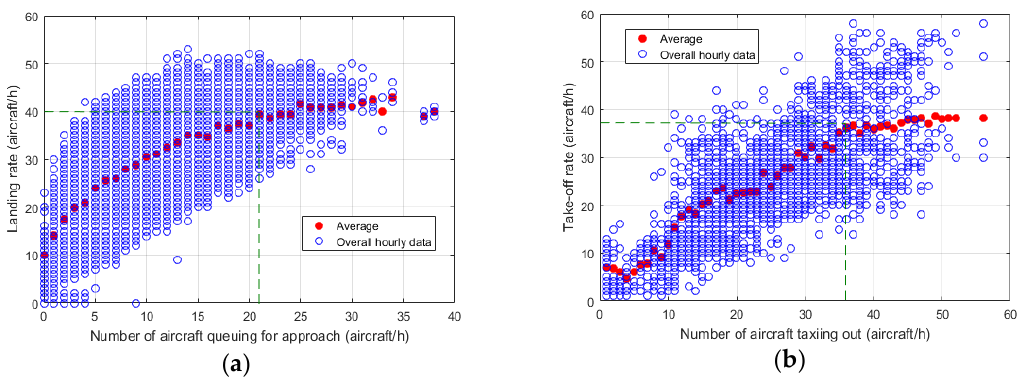
Figure 23. ( a ) Average landing rate as a function of the number of queuing aircraft; and ( b ) average take-off rate as a function of the number of departing aircraft on the ground.